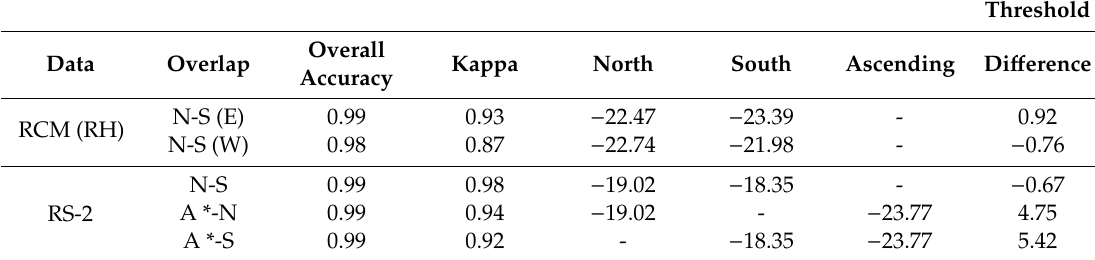
Table 2. Summary and comparison of automatically derived thresholds for Radarsat-2 (RS-2) and Radarsat Constellation Mission (RCM) scenes for areas of overlap. Note, N-S corresponds to north–south overlap, where N-S (E) relates to east areas of north–south overlap, and N-S (W) similarly relates to west areas. A-N corresponds to ascending and north RS-2 scene overlap, and A-S similarly corresponds to ascending-south overlap. The di ff erences between scene thresholds are calculated as noted in overlap (e.g., N-S denotes the south image threshold being subtracted from the north image